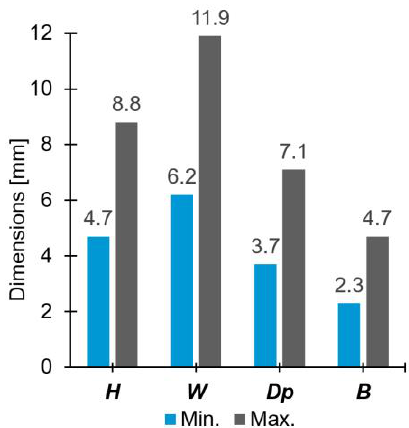
Figure 4. Maximum and minimum values of the rivet dimensions within the joint formation evaluation.